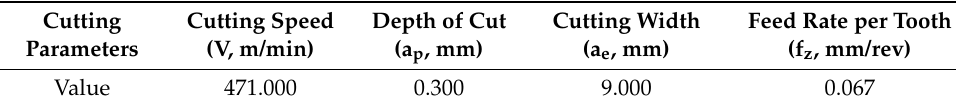
Table 3. The cutting parameters of 7050 aluminum alloy.